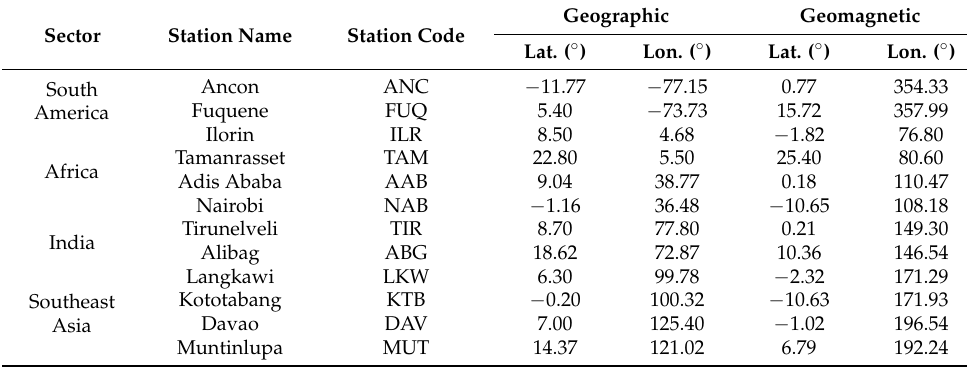
Table 1. Geographic and geomagnetic coordinates for ground